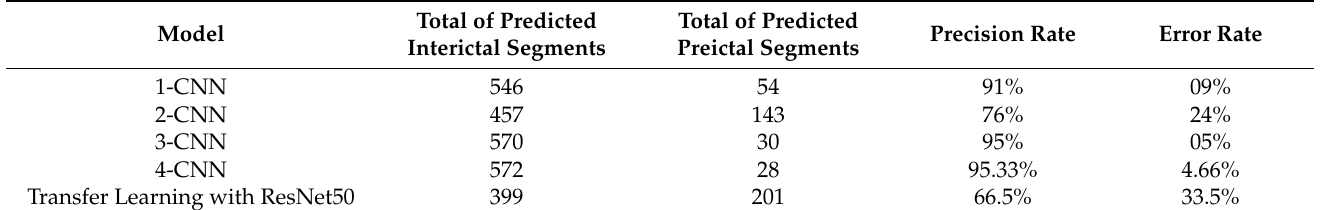
Table 1. Precision and error rate of 1-CNN, 2-CNN, 3-CNN, 4-CNN, and transfer learning with ResNet50 models.